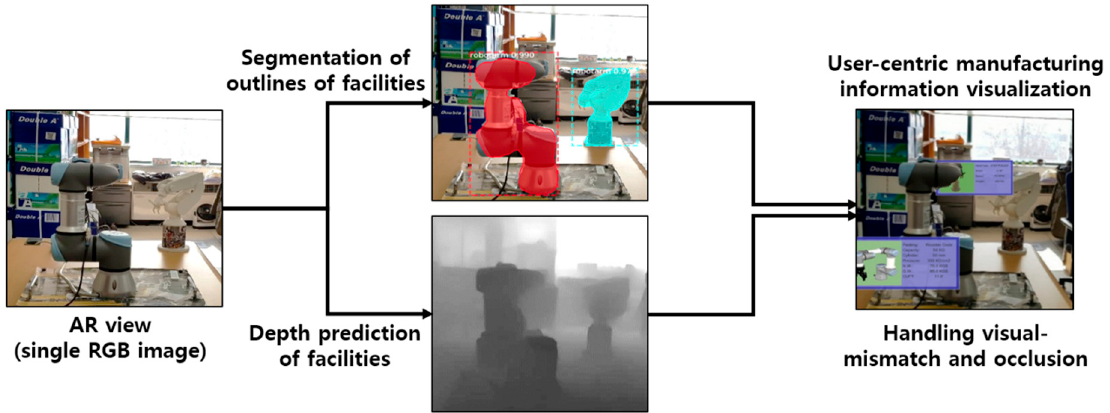
Figure 2. Proposed industrial AR using facility segmentation and depth prediction.